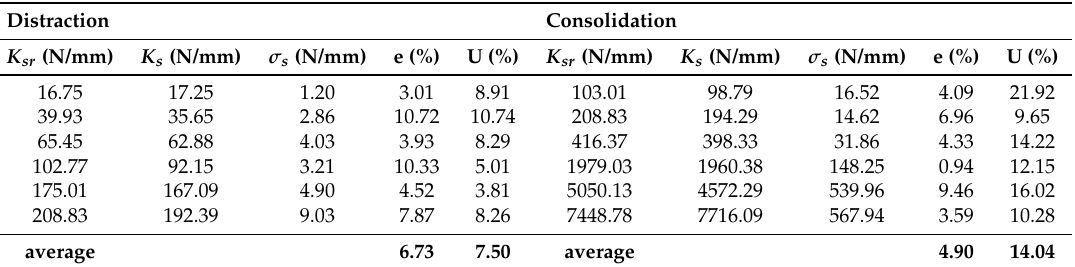
Table 1. Results from the calibration test. K sr : stiffness of the elastic-spring. K s : stiffness estimated with the bone-fixator model. σ s : standard deviation of the stiffness estimations e: error in the estimated stiffness value. U: Uncertainty from reference, repetition and replication